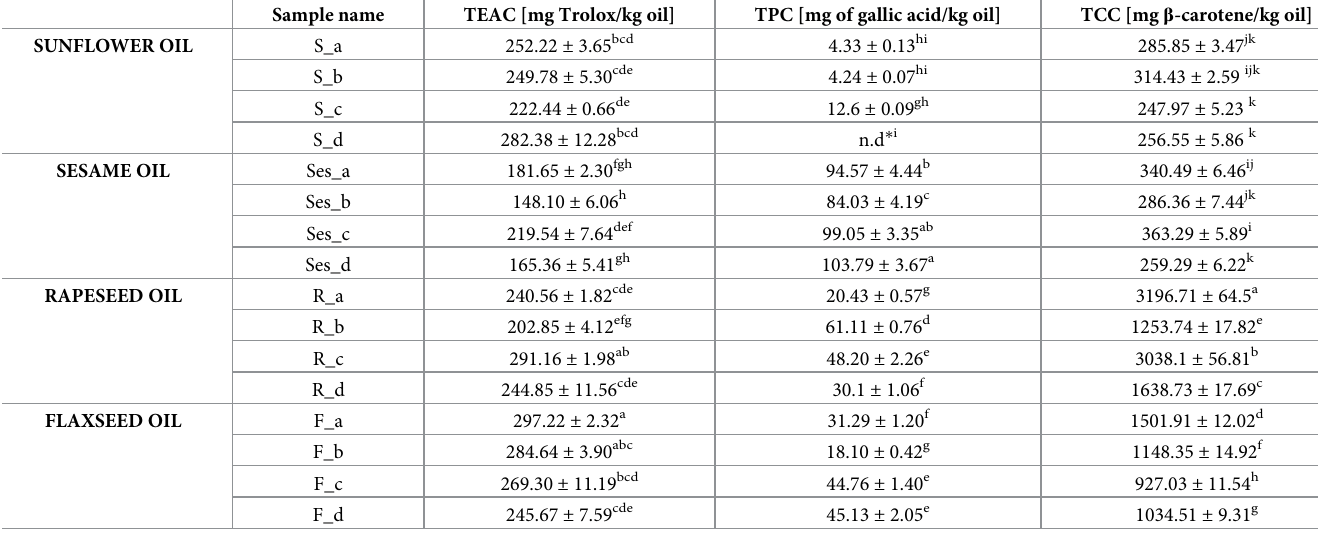
Table 2. Trolox equivalent antioxidant capacity (TEAC), total phenolic content (TPC) and total carotenoid content (TCC) of the oil